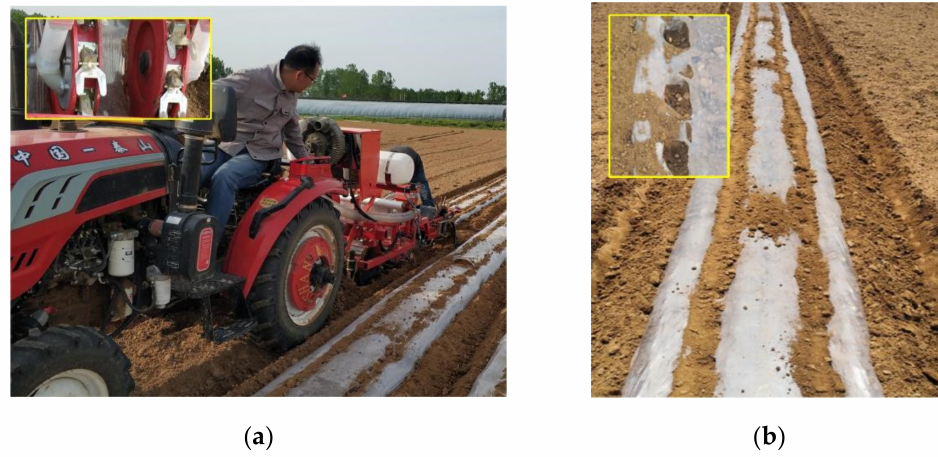
Figure 11. ( a ) Field trial verification; ( b ) seeding on